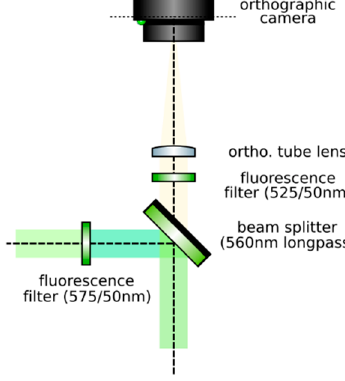
Figure 9. Insert a beam splitter and two fluorescence filters before the tube lens.